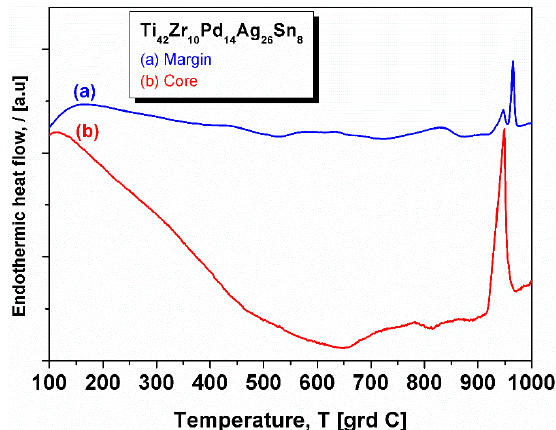
Figure 6. DSC thermograms of the 5 mm diameter rod: ( a ) sample taken from margin; ( b ) sample taken from the core.